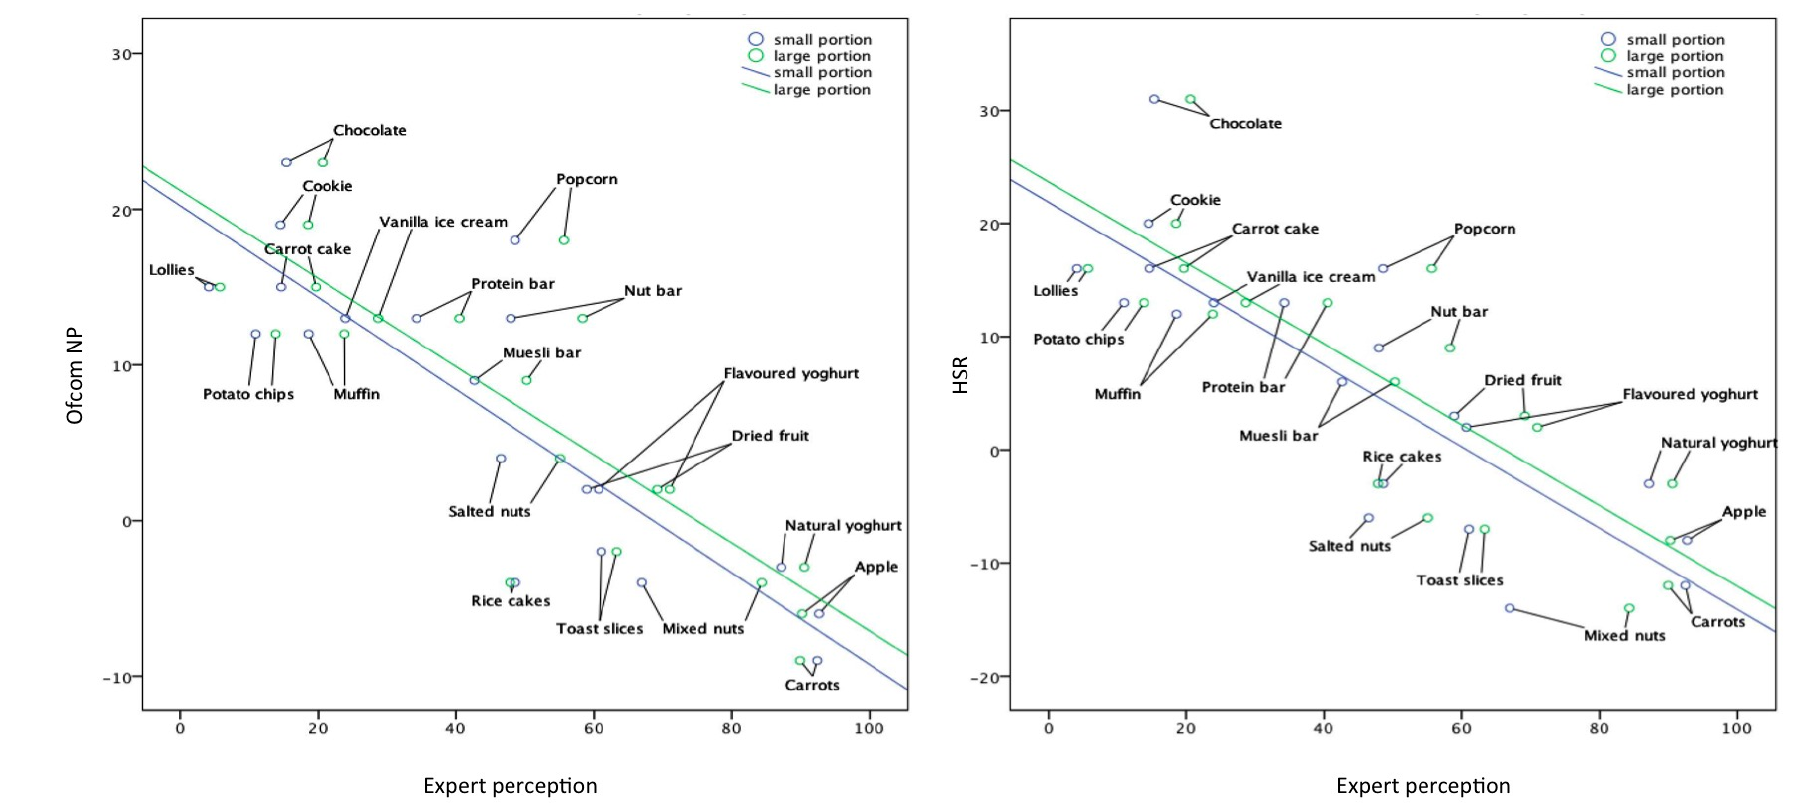
Figure A1. Perception of “nutritiousness” of 20 different snacks by nutrition experts ( N = 206) versus Ofcom Nutrient Profile scores (Ofcom NP; left ) and Health Star Rating score (HSR, right ). Experts evaluated 20 snacks in a small portion (blue) size and a large (green) portion size on a scale ranging from (not nutritious) to 100 (very nutritious). Lines indicate linear regressions. Biases for certain foods are visible such as chocolate, which is rated as more nutritious than expected from nutrient profile scores and “lollies” were ranked as less nutritious.